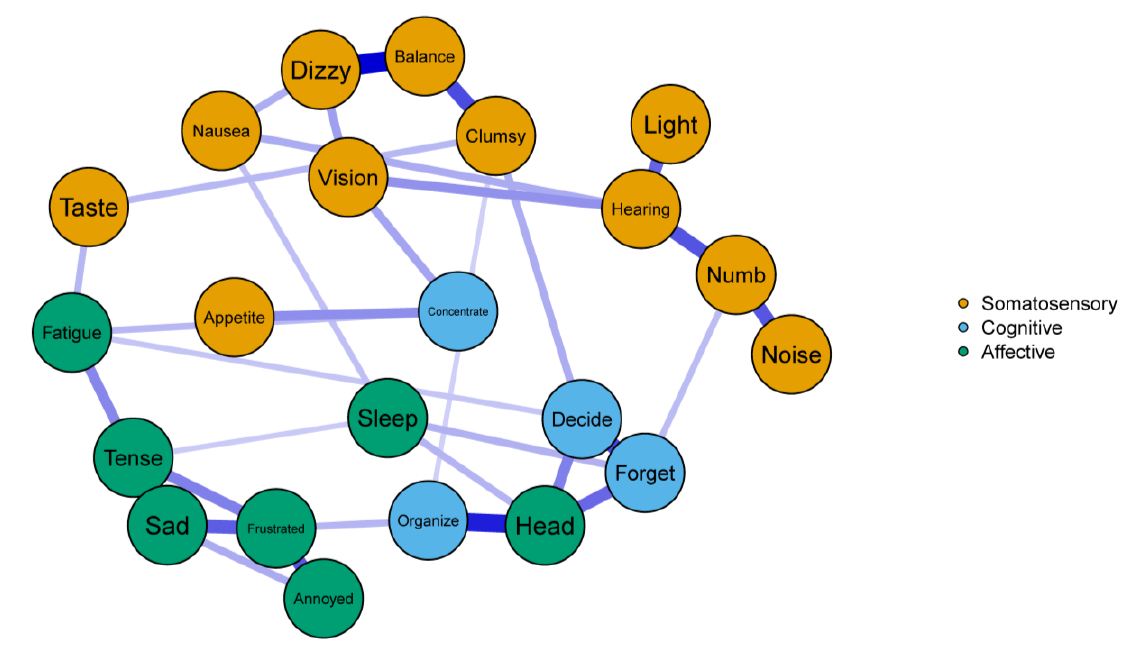
Figure 2. The COVID+ network. Solid edges indicate positive associations with width and depth of color indicating the strength of associations.